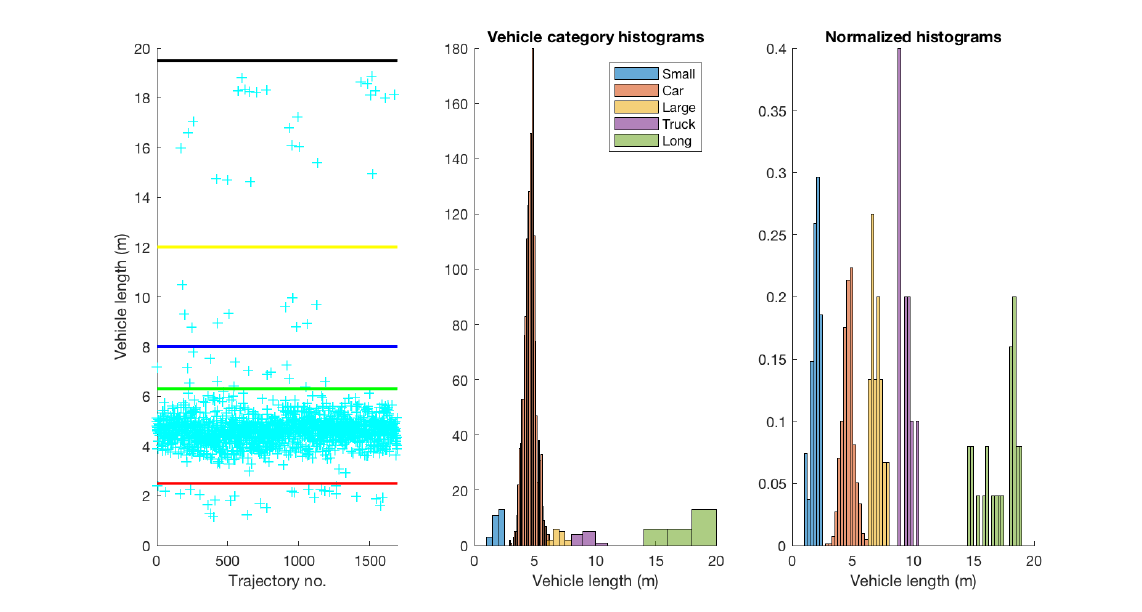
Figure 5. Vehicles categorised by length into five categories, namely small, car, large, truck and long vehicles: ( a ) each instance (unique vehicle in the dataset) is represented by a cyan cross with the upper boundaries for the smallest to longest categories represented by the red, green, blue, yellow and black lines, respectively; ( b ) histograms for each length-based vehicle category; and ( c ) normalised